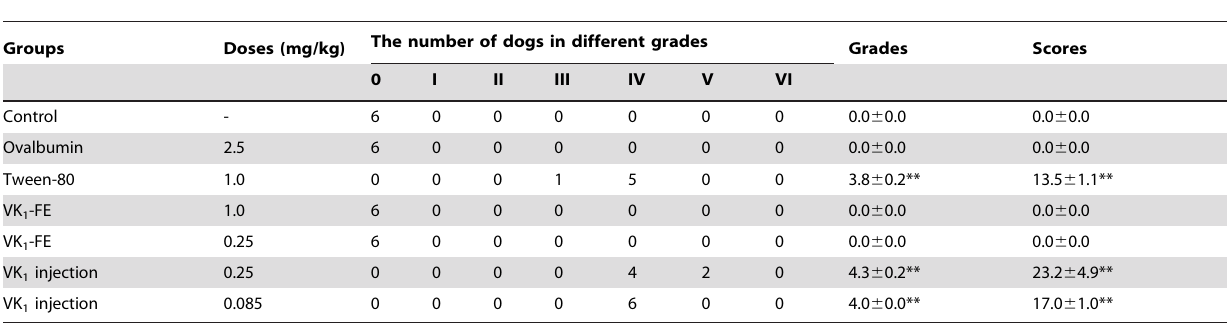
Table 2. Grades and scores for anaphylactoid reactions in dogs after the first intravenous administration.